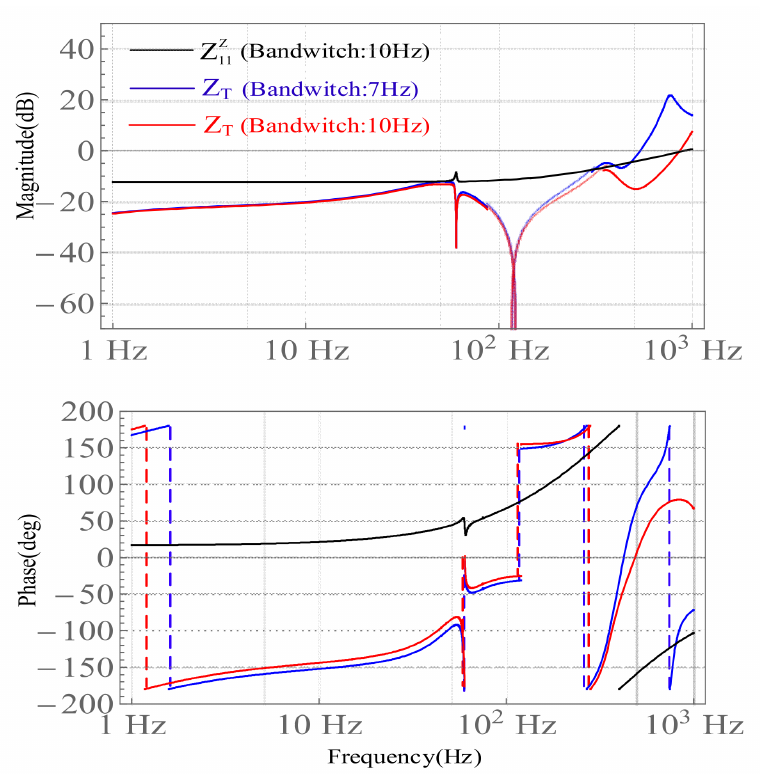
Figure 6. Impedance curves with different PLL bandwidths ( Z Z sequence perturbation without frequency coupling. Z T is the entire impedance of DFIG system considering the cross-coupling